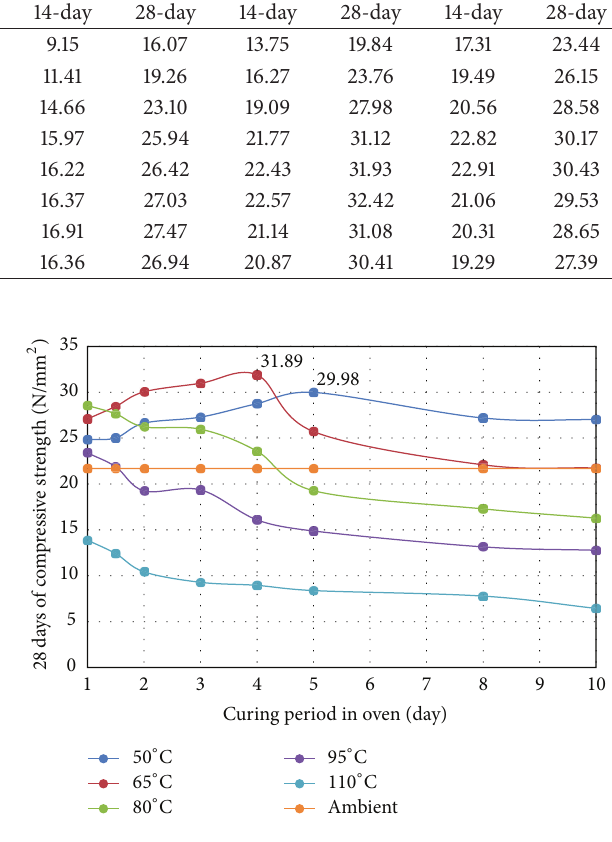
Figure 15: Compressive strength of OPSGPC at different curing temperatures for different curing periods (the specimens were kept in ambient condition after oven curing period till the test day of the 28